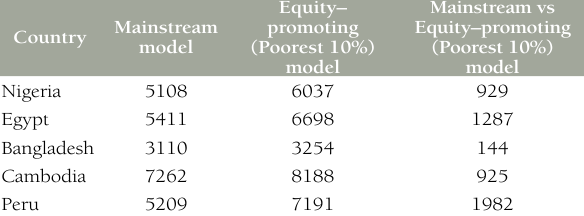
Table 3 Number of lives saved for US$ 1 million investment according to Mainstream vs Equity–promoting model Country